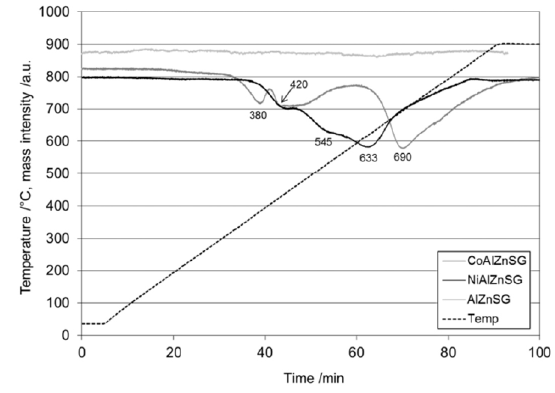
Figure 3. TPR profiles of the catalysts prepared by the sol-gel method: solid line – H2 signal, dotted line – tempera- ture.